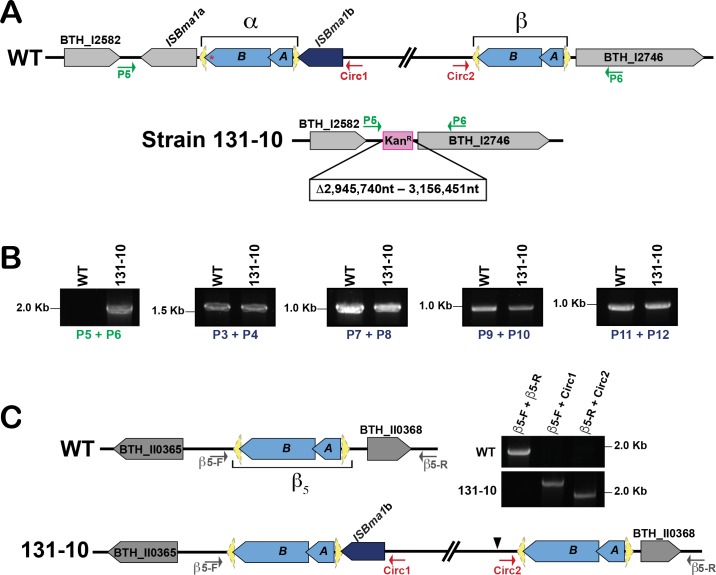
The IS2-like Translocatable unit mobilized to chromosome II in the 131–10 strain.(A) Graphical representation of the region in chromosome 1 where the bcpAIOB-containing composite transposon is located (top). Graphical representation of strain 131–10 in which the entire composite transposon has been replaced by an nptII cassette (bottom). (B) PCR analyses to confirm removal of the MGE in strain 131–10 using primers P5 and P6 (shown as green arrows in panel A). PCR analyses detect DNA corresponding to genes within the composite transposon in strain 131–10. (C) IS2β5 in chromosome II in a WT background (top), or upon insertion of the IS2-like translocatable unit (bottom). PCR analyses of WT and strain 131–10 to confirm the insertion of the IS2-like translocatable unit into chromosome II. The distance between the binding site of primers β5-F and β5-R (grey arrows) is approximately 1.8 kb in WT DNA. Primers Circ1 and Circ2 (red arrows) bind specifically to the ends of the mobilized bcpAIOB-containing element. The insertion site of pABT73-TMP is denoted with a black arrowhead.